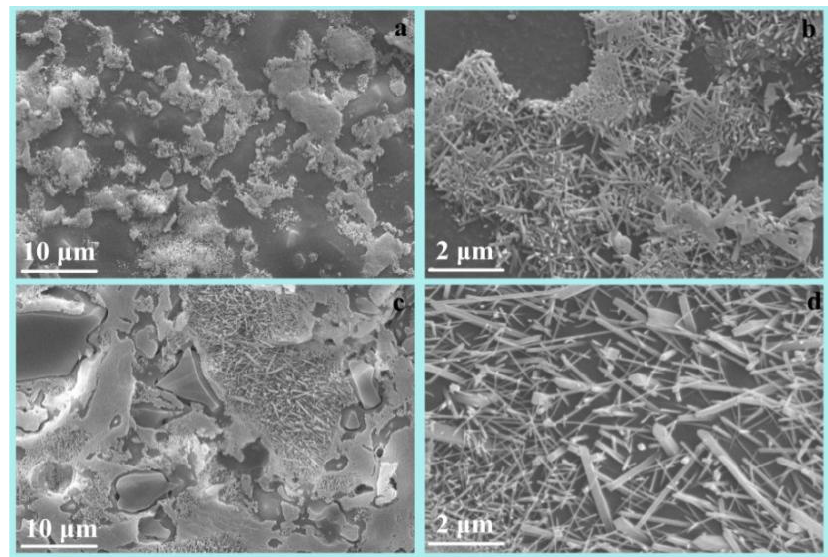
Figure 5. SEM images of M at 1513 K ( a , b ) and 1543 K ( c , d ). Decreases were observed in the size of pore and the amount of glass phase formed in M at 1513 K (Figure 5a), compared with the morphology of R at 1603 K. At the same time, numerous tiny needle-shaped crystal were formed in M at 1513 K (Figure 5b); the interlocked crystals were identified as anorthite and mullite by XRD (Figure 3). The cross- linking anorthite/mullite crystals likely resulted in the higher bending strength of M (Table 4). When the sintering temperature increased from 1513 K to 1543 K, the anorthite crystals disappeared (Table 5) and the mullite became more stick-shaped (Figure 5d). These results suggested that mixing additives into the raw material could achieve a desired microstructure at a lower sintering temperature. The needle-shaped anorthite/mullite crystal improved the mechanical performance of the ceramics. The small reduction in the bending strength, which decreased at 1543 K (Table 4), was due to the disappearance of the anorthite crystal, the decrease in the aspect ratio of the mullite, and the increase in the glass phase; the mechanical properties of the glass phase were worse than those of the